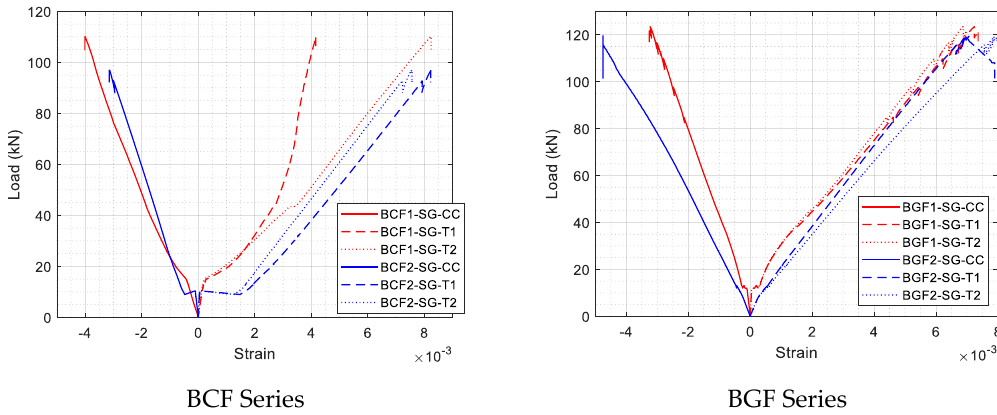
Figure 9. Load vs. strain curve of the fibre-reinforced polymer (FRP)-reinforced geopolymer beams.